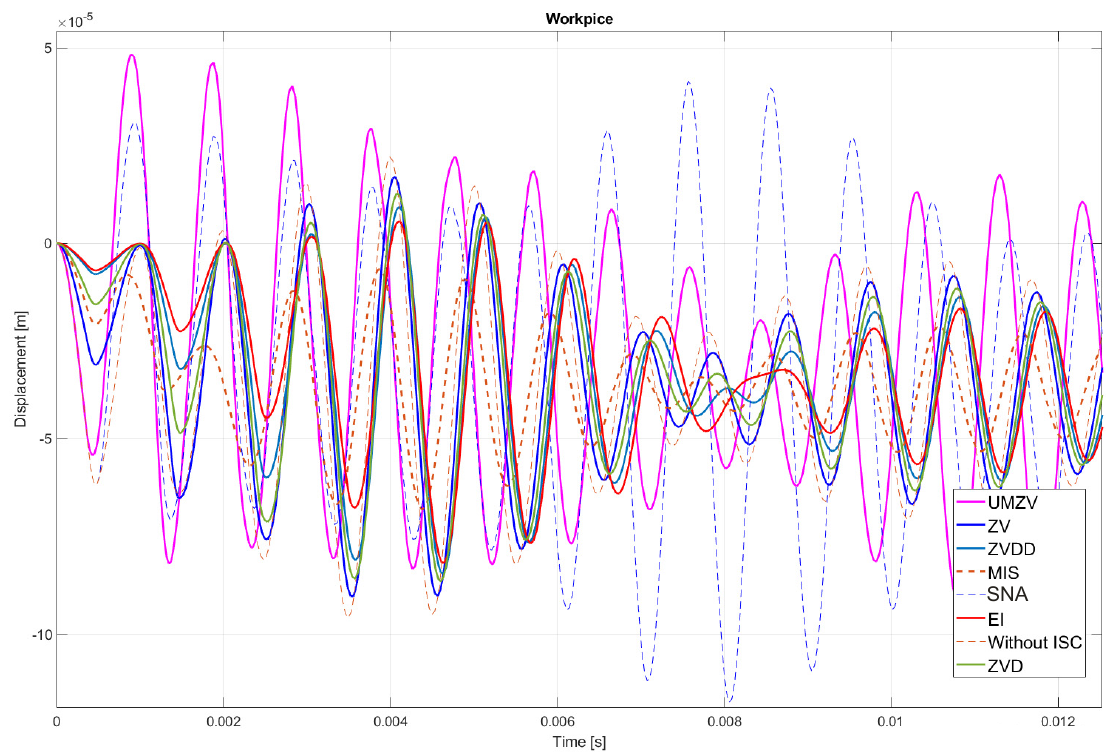
Figure 12. Work piece displacement during rough machining: without ISC control, using UMZV, ZV, ZVD, ZVDD, MIS, SNA and EI algorithm.